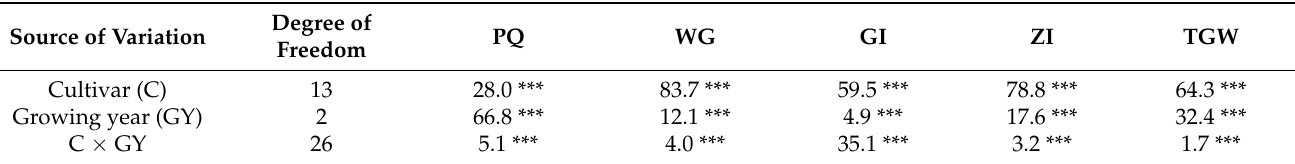
Table 8. ANOVA mean square per source of variation as percentage of total for indirect baking quality